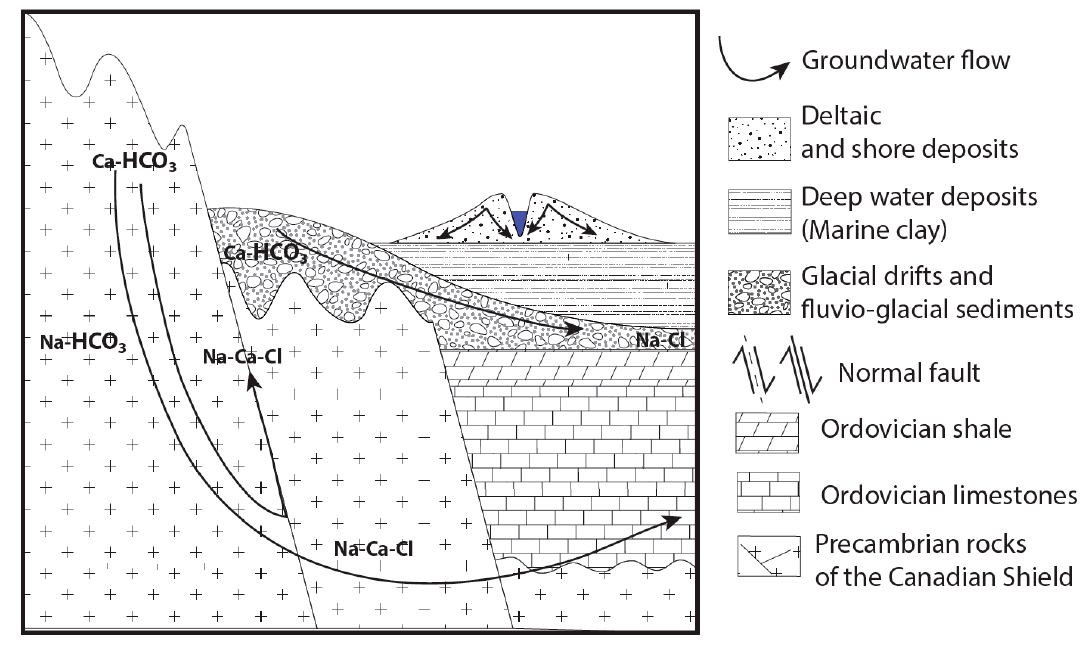
Figure 3. Conceptual cross-section showing the two paths followed by groundwater mineralization towards a brackish endmember in the Saguenay-Lac-Saint-Jean region (modified from Walter et al. [5]).